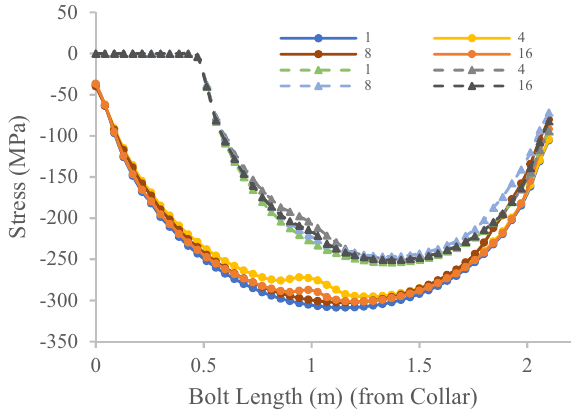
Fig. 9 Stress distribution along 2.1 m fully grouted (circle-solid line) and partially grouted (triangle-dash line) HSAC840 steel bolt for a selected number of clay band iterations. Description of Clay Band models is listed in Table